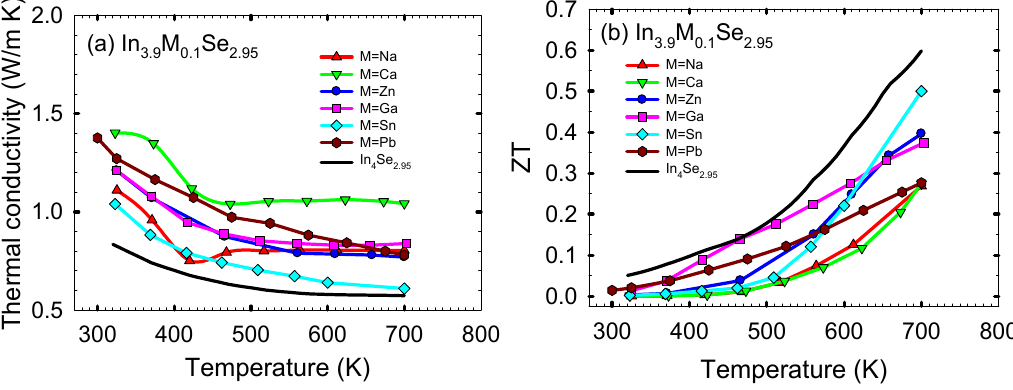
Figure 12. ( a ) Temperature dependence of thermal conductivity, and ( b ) the thermoelectric figure of merit of polycrystalline samples of In 3.9 M 0.1 Se 2.95 (M = Na, Ca, Zn, Ga, Sn, Pb) and In 4 Se 2.95 . Reproduced with permission from AIP Publishing LLC, 2011